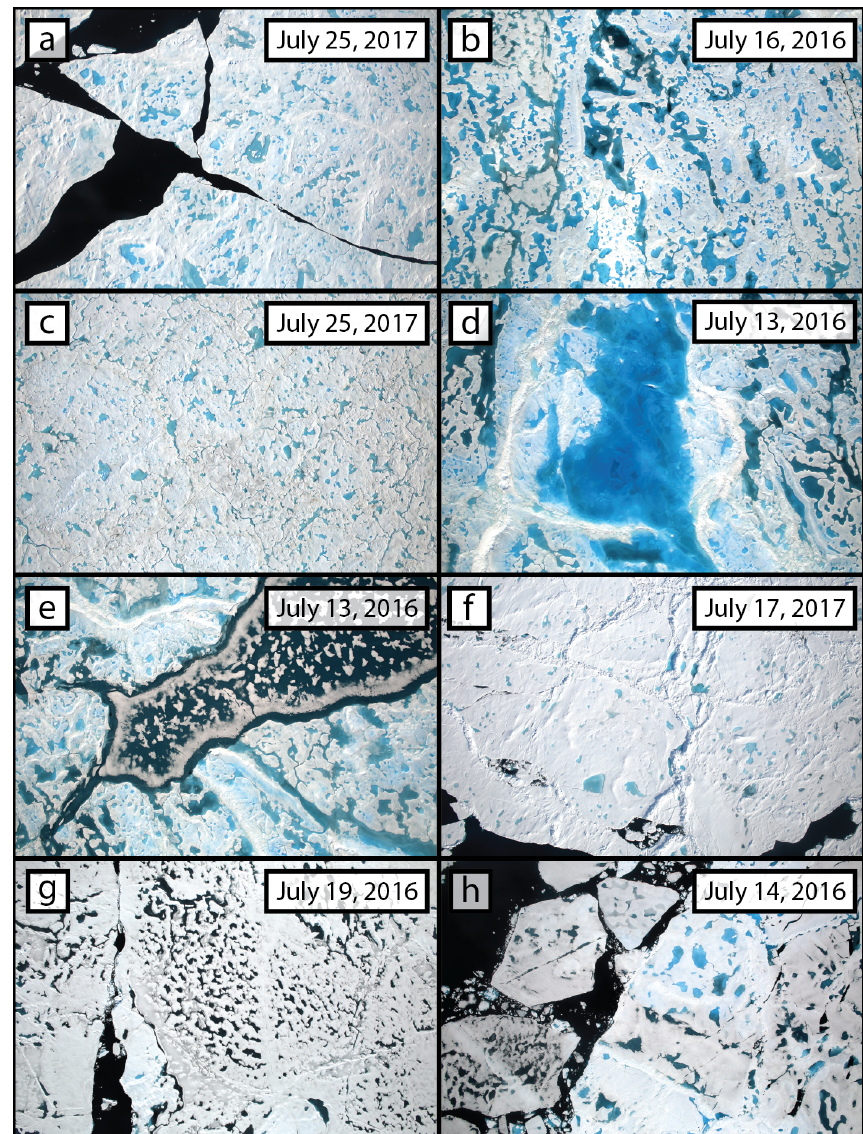
Figure 11. Exhibits of sea ice surface features as seen in the DMS dataset. Each panel is a full IceBridge image, and while flight altitude affects image resolution and footprint, each scene is approximately 600m by 400m. See text for full description of each